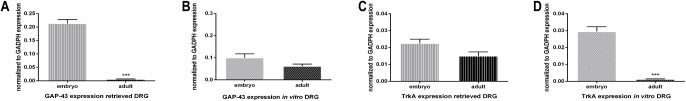
Expression of growth-associated protein 43 (GAP-43) and tropomyosin receptor kinase A (TrkA).Quantification by RT- qPCR of GAP-43 (A, B) and TrkA (C, D) mRNA expression in retrieved and in vitro embryonic and adult DRG (n = 4–10). Data represented as mean ± SEM. Two-way ANOVA was performed followed by Tukey’s post-hoc multiple comparison test (* p<0.05; ** p<0.01; *** p<0.001).